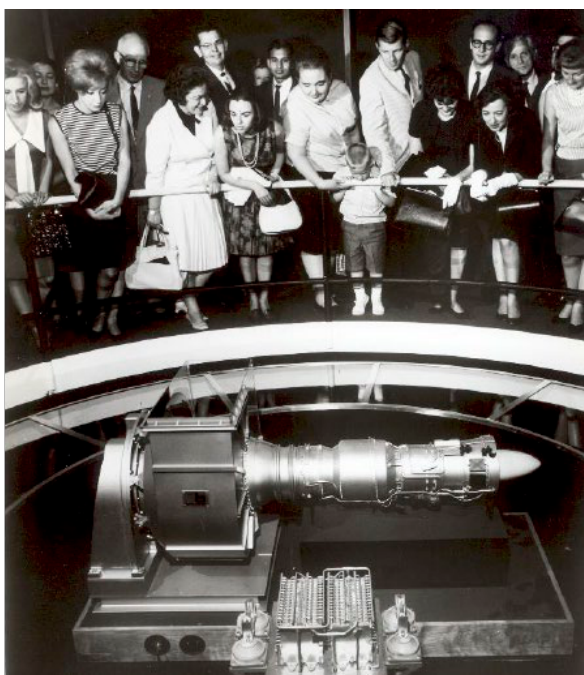
Figure 12. Fuel cell and gas turbine at the 1964 World’s Fair. From